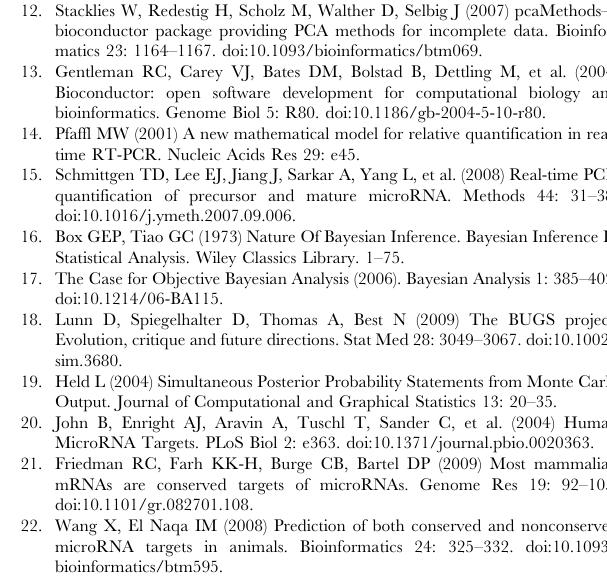
Figure S2 Raw signals (C t ) of microRNA controls classified according to patient clinical status and plate (A or B) for each of the 53 qPCR panels used in this study. hsa-miR-103/191/423-5p: endogenous microRNA con- trols in the Exiqon platform per manufacturer, U6/SNORD38B/ SNORD49A: small RNA endogenous controls, BLANK: Empty PCR wells, UniSP6: Spiked Control (included in 50% of plates), UniSP3: Spiked Inter-Plate Calibrator (included in 100% of plates). Signal reproducibility appeared to be higher for the spiked- in controls than the endogenous ones; furthermore there did not appear to be a substantial inter-plate difference to justify the use of Inter-Plate Calibration. Table S1 Names and accession numbers of microRNA species analyzed in this study. miRBase names prior to the 18 th release are included as well to facilitate comparison with earlier literature. Retired entries in the 18 th release of miRBase